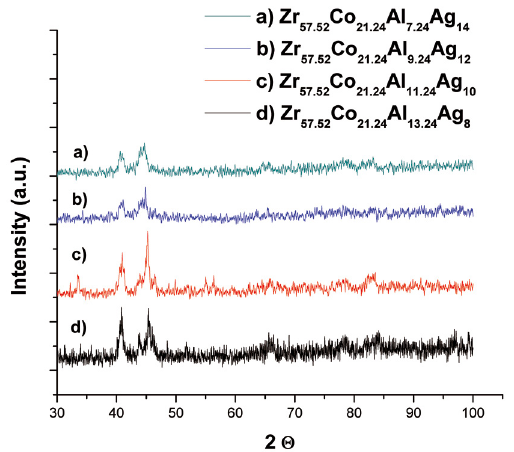
Figure 2: XRD patterns for Zr-Co-Al-Ag alloys of 3 mm cross-section.